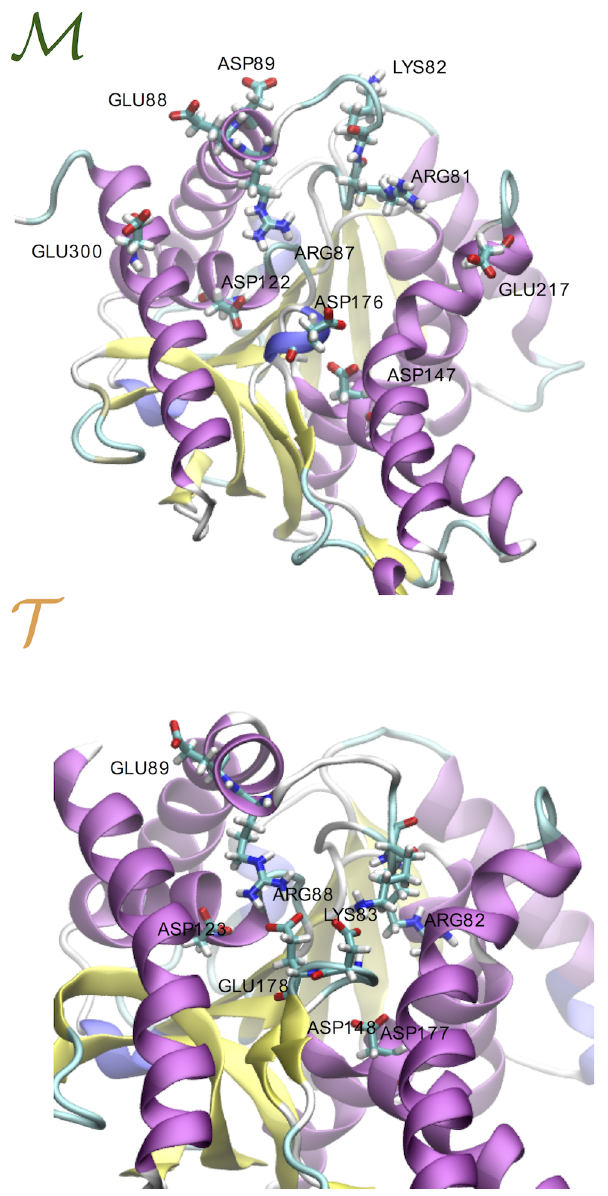
Figure 4. Salt-bridges at the external loop of the catalytic pocket. (Top) Mesophilic tetramer. The ion pairs (IPs) that form during the 200 ns simulation are Arg81-Glu217, Arg81-Asp147 and Arg81-Asp176, Lys82- Asp89 and Arg87-Asp176, Arg87-Asp122, Arg87-Glu300 and Arg87-Glu88. (Bottom) Thermophilic tetramer. The IPs that form during the 200 ns simulation are Arg82-Asp148, Arg82-Asp177 and Arg82-Glu178, Lys83- Asp177, Lys83-Glu178 and Lys83-Asp123 and Arg88-Glu178, Arg88-Asp123 and Arg88-Glu89.